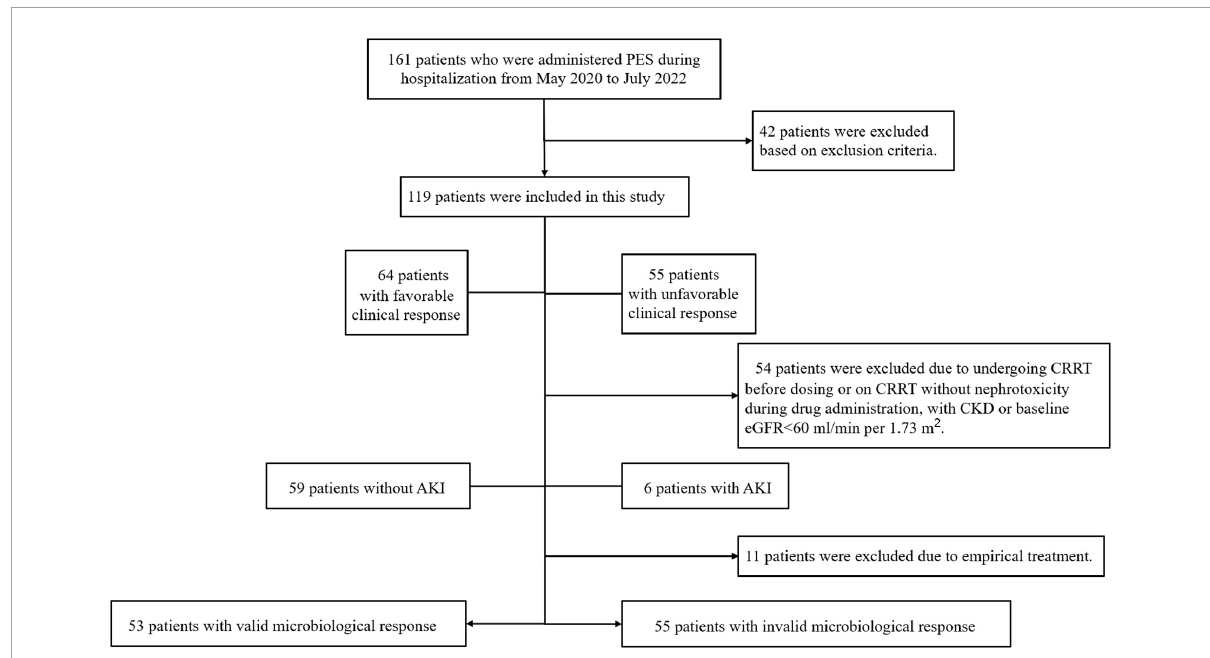
FIGURE1 Study grouping and flow chart. PES, polymyxin E sulfate; CRRT, continuous renal replacement therapy; CKD, chronic kidney disease; AKI, acute kidney injury.